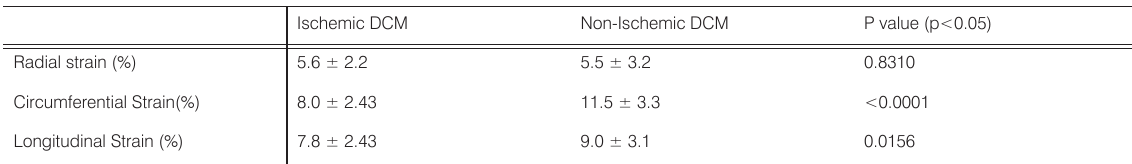
Table 4. Radial, Circumferential and Longitudinal strain evaluation through tissue Doppler imaging and 2-D speckle tracking in patients with ischemic and non-ischemic dilated cardiomyopathy: Circumferential and Longitudinal Strains are significantly reduced in patients with ischemic dilated cardiomyopathy; there was not a difference with respect to the radial strain. DCM: Dilated Cardomyopathy. Ischemic